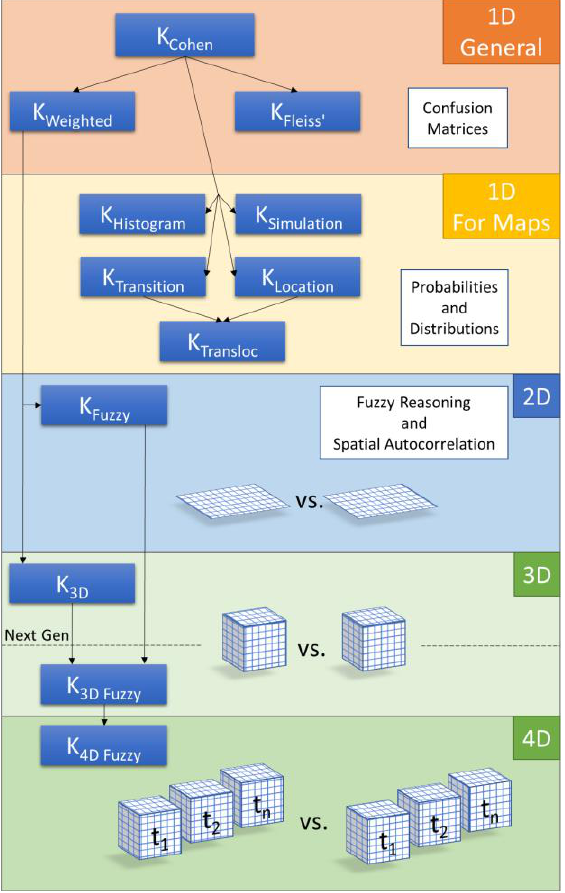
Figure 1 . Hierarchy of Kappa approaches originating from Cohen’s